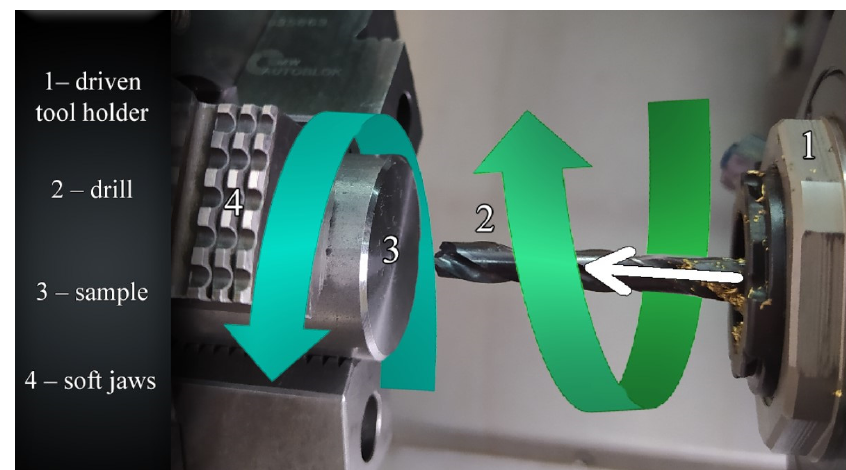
Figure 3. Third kinematic system.